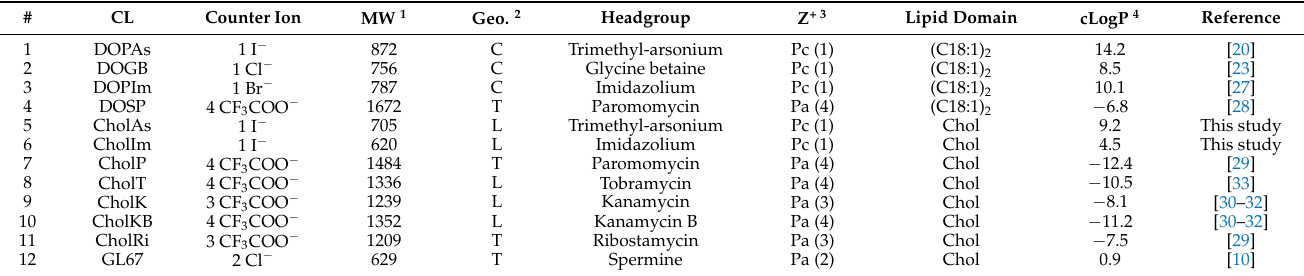
Table 1. Structural features of the cationic lipids investigated.